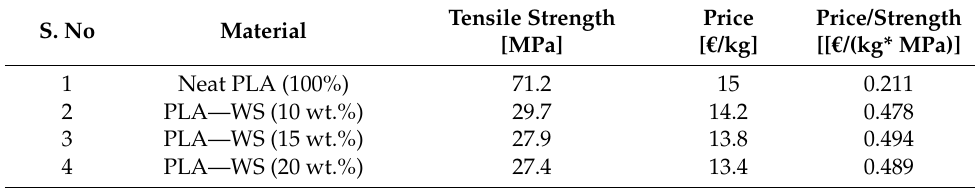
Table 4. Cost analysis of PLA filled with walnut shell